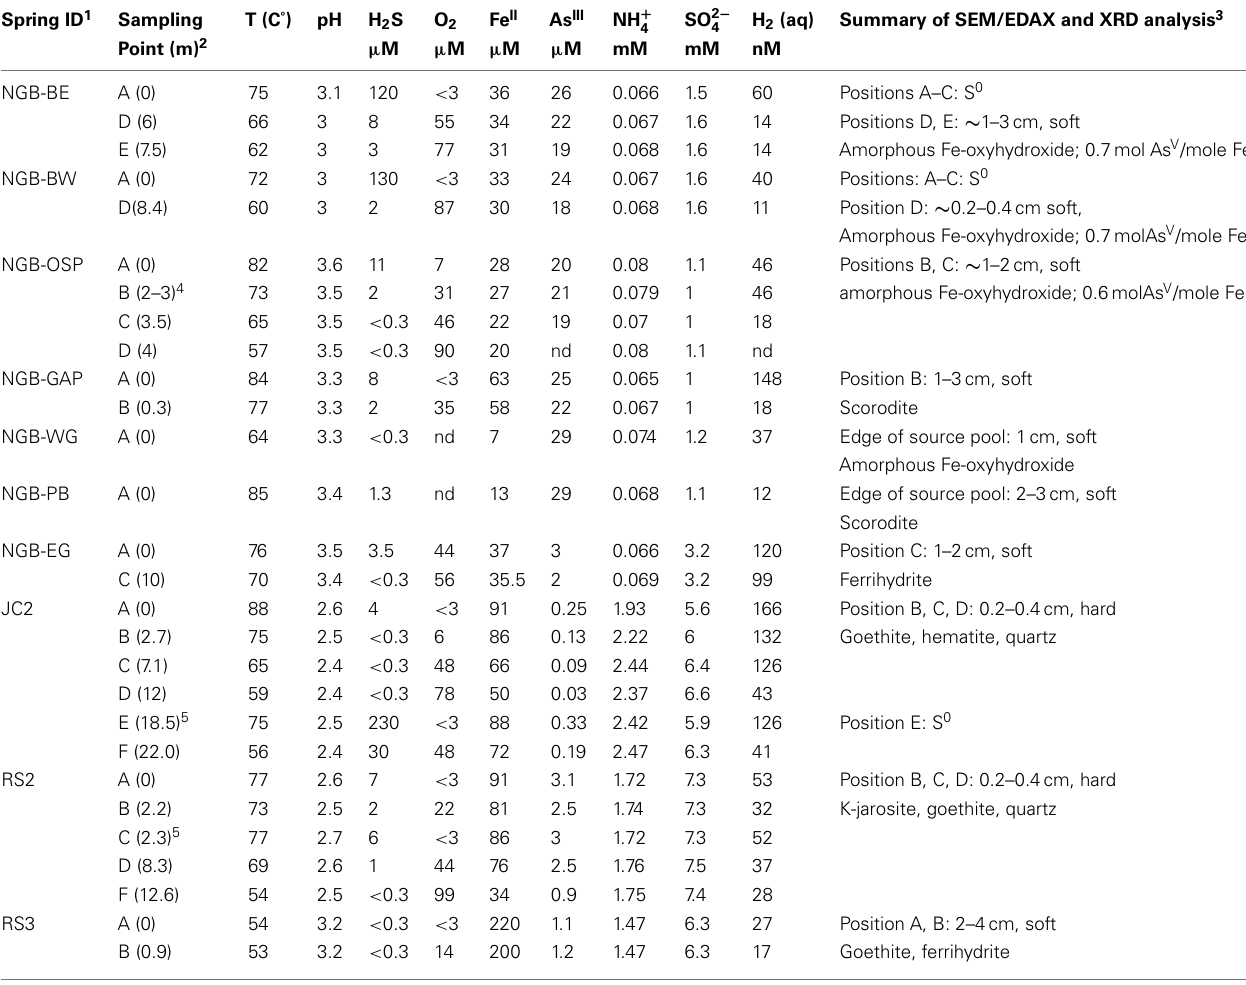
Table 1 |A geochemical summary of acid-sulfate-chloride springs (Norris Geyser Basin) and acid-sulfate springs (Joseph’s Coat and Rainbow Springs) showing concentrations of major electron donors, O 2 and solid phase analysis using synchrotron X-ray